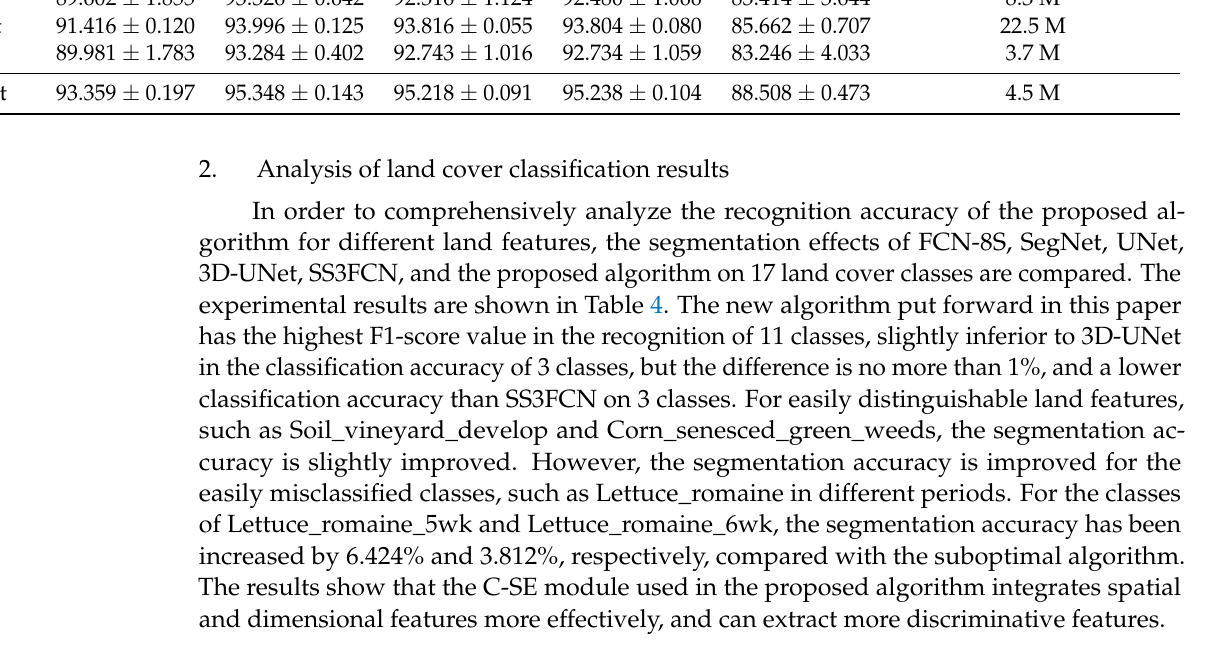
Table 4. Comparison of segmentation accuracy for different classes with different algorithms (F1-score